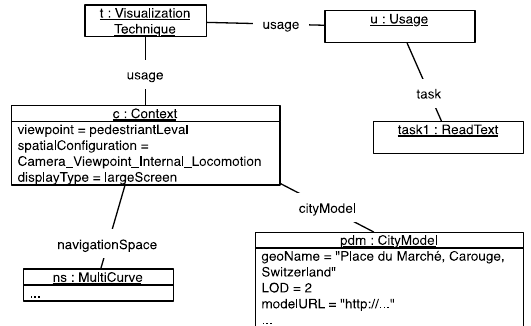
Figure 7. Description of the usage of a